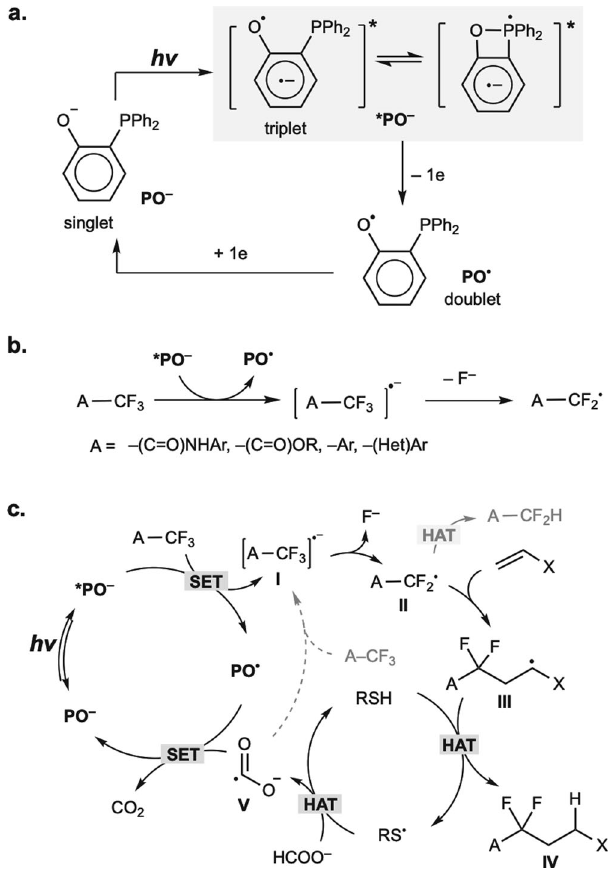
Fig. 1 o -Phosphinophenolate as photocatalyst for C – F functionalization of – CF o -phosphinophenolate ( PO – ) as 3 . a Design of a system that uses